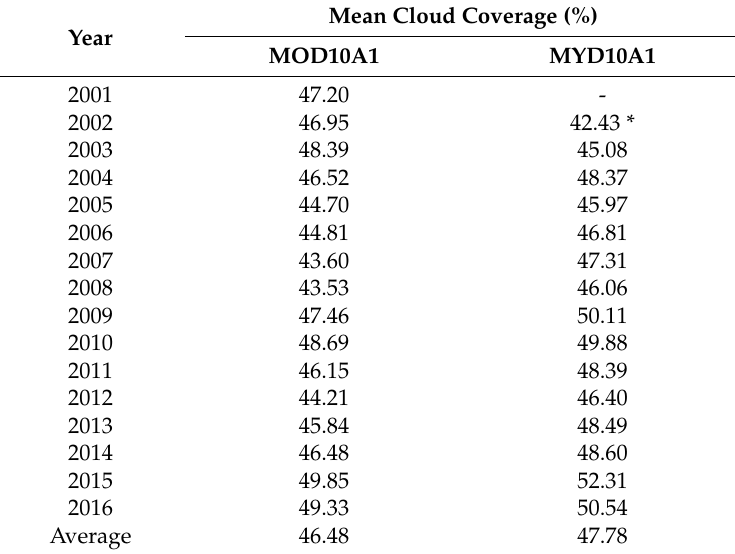
Table 2. Mean cloud coverage in the MODIS SCF products.